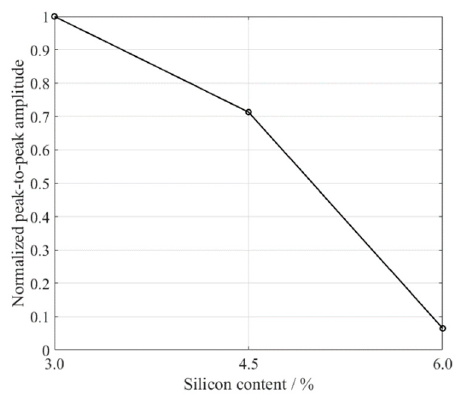
Figure 10. The peak-to-peak amplitude of the S0 Lamb wave versus the silicon content (normalized).